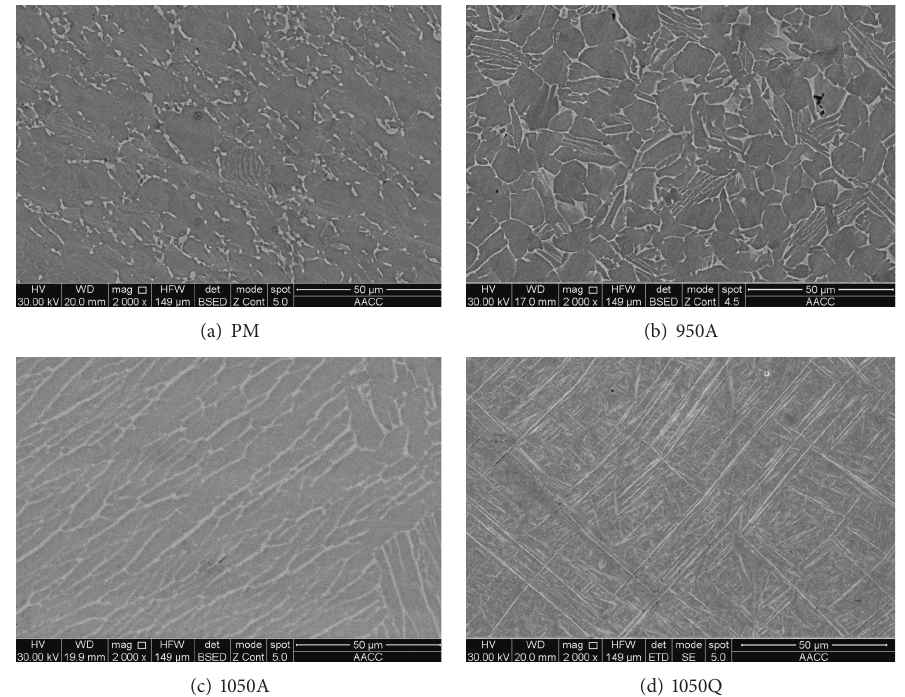
Figure 4: SEM backscattered electron images of AR-PM, 950A, 1050A, and